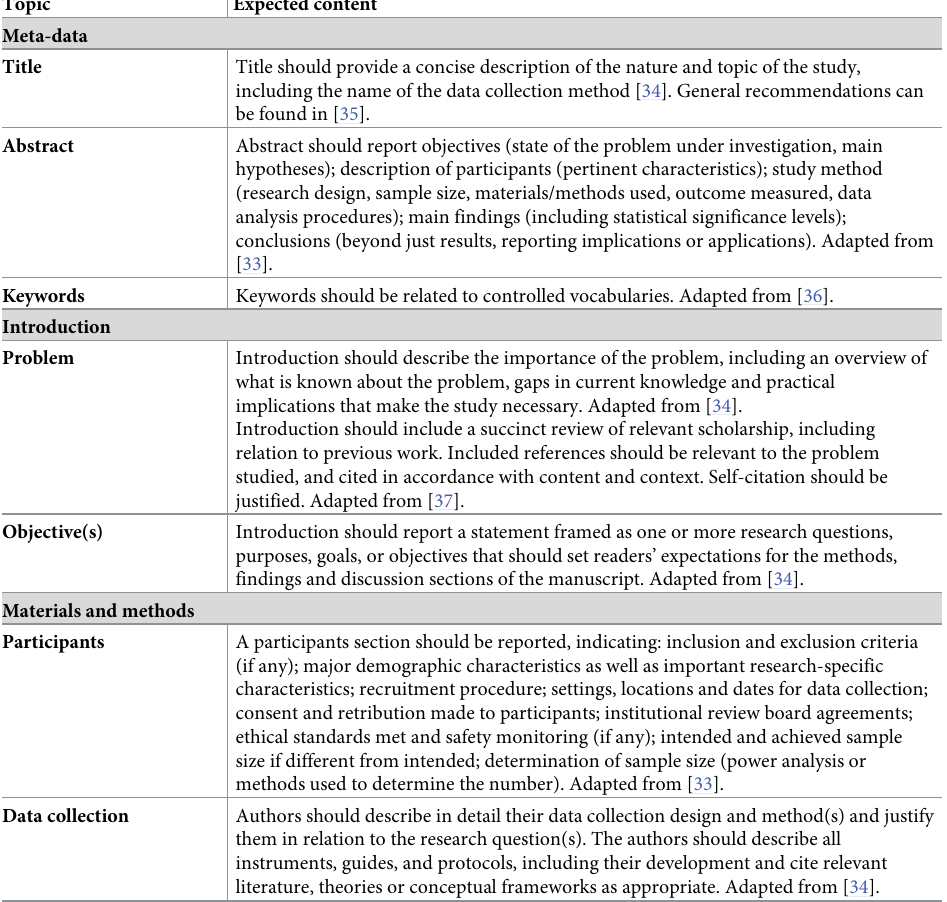
Table 4. Generic standards applicable for reporting studies involving temporal sensory methods, adapted from